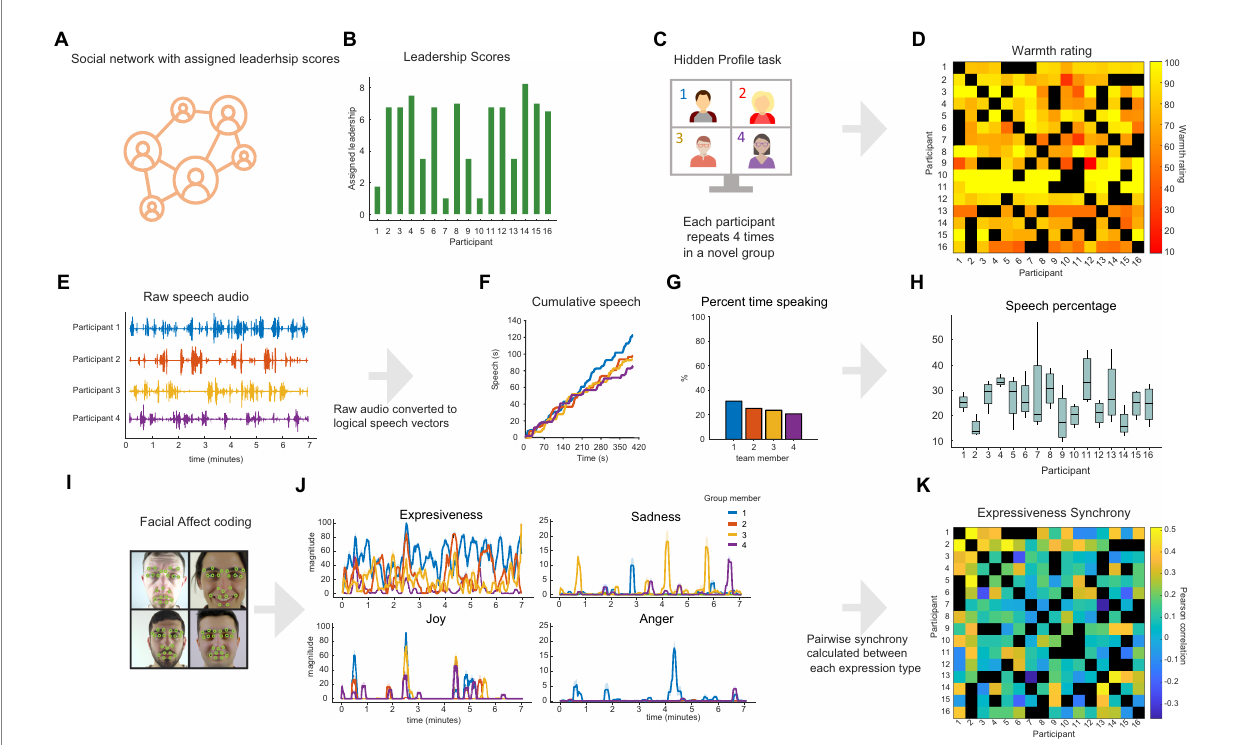
FIGURE 1 Experimental approach and analysis pipeline: (A) Quantified social network, (B) Leadership scores of participants in social network. (C) Hidden profile task schema. (D) Ratings of participants on warmth and competence from other participants. (E–G) Example data from session 10, (E) Raw speech waveforms (F) cumulative speech over session durations (G) Percentage of total speech by each participant. (H) Percentage of speech by each participant in each session. (I) Facial affect coding shema. (J) Example facial affect time course from session 10, Engagement, Joy, Sadness and Anger (K) pairwise synchrony between interacting participants, black squares indicate participants that did not interact. Faces created with AI software (https://stablediffusionweb.com/) License: CC0 1.0 Universal Public Domain